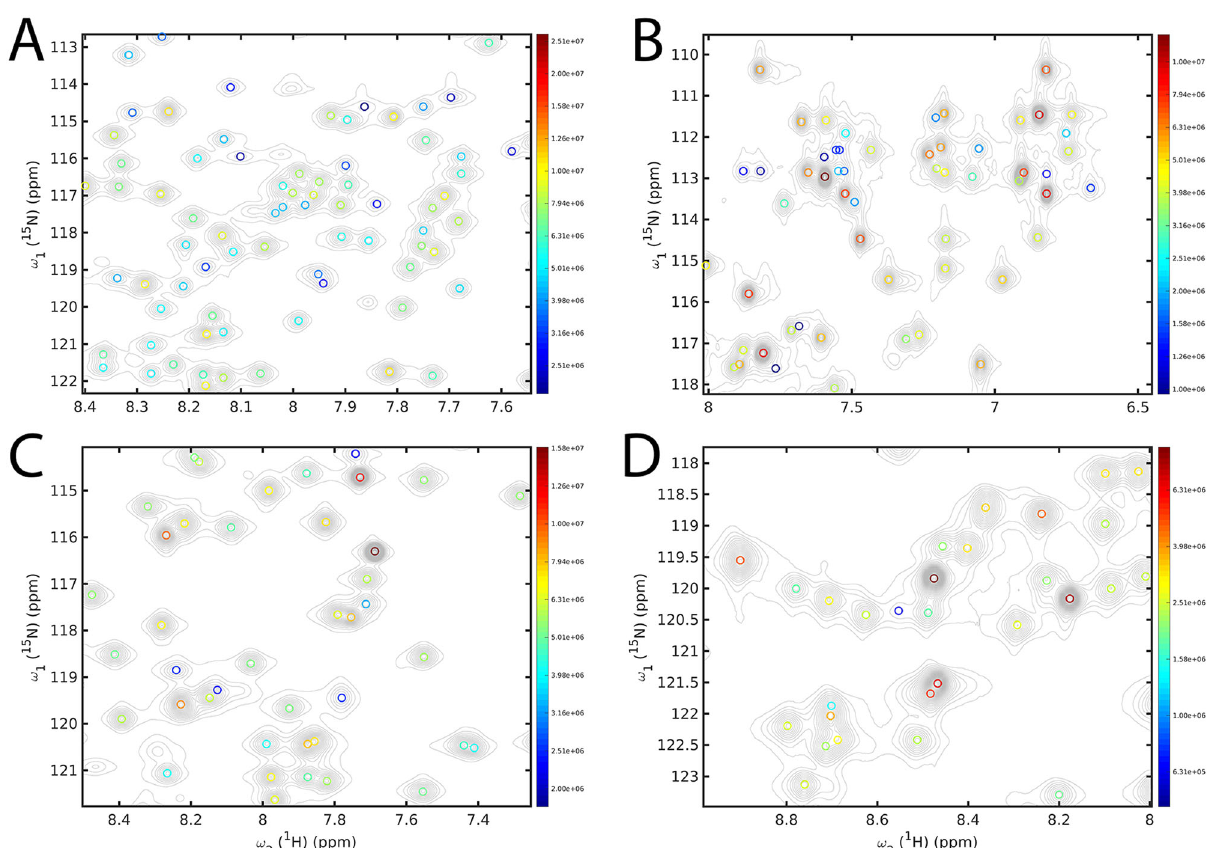
Fig. 6 Illustration of peak-picking performance of DEEP Picker for four different proteins. Selected regions of 2D 15 N – 1 H HSQC spectrum of the four different proteins A Gankyrin, B PLA2, C ARID, and D Rop. Picked cross-peaks by DEEP Picker are indicated as circles and color-coded according to their amplitude on a logarithmic scale, whereas the contour line spacings are linear. Experimental information and enlarged plots of each spectrum are given in the Supporting Information. Some of the weakest cross-peaks (small number of contours) were not picked because they are below the noise cutoff used by DEEP